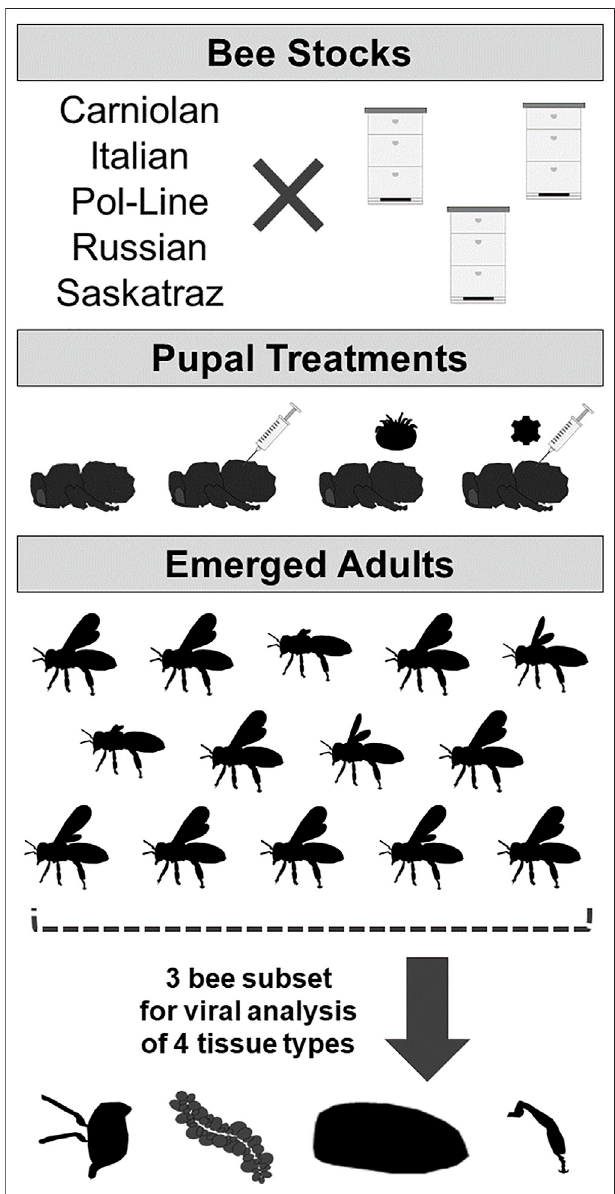
FIGURE 1 | Experimental design: experimental design to determine DWV symptoms and levels based on bee stock and treatment of white-eyed pupae (no injection control/naturally occurring infection, PBS sham injection, Varroa miteexposure,orsublethalDWVinjection).DWVsymptomswere analyzed in emerged adults (N = 12 – 17 bees per stock/treatment combination);then asubsetofthreebeeswasdissectedintofourtissuetypes (heads, hypopharyngeal glands, abdomen, and rear legs) subsequently used for viral analyses.